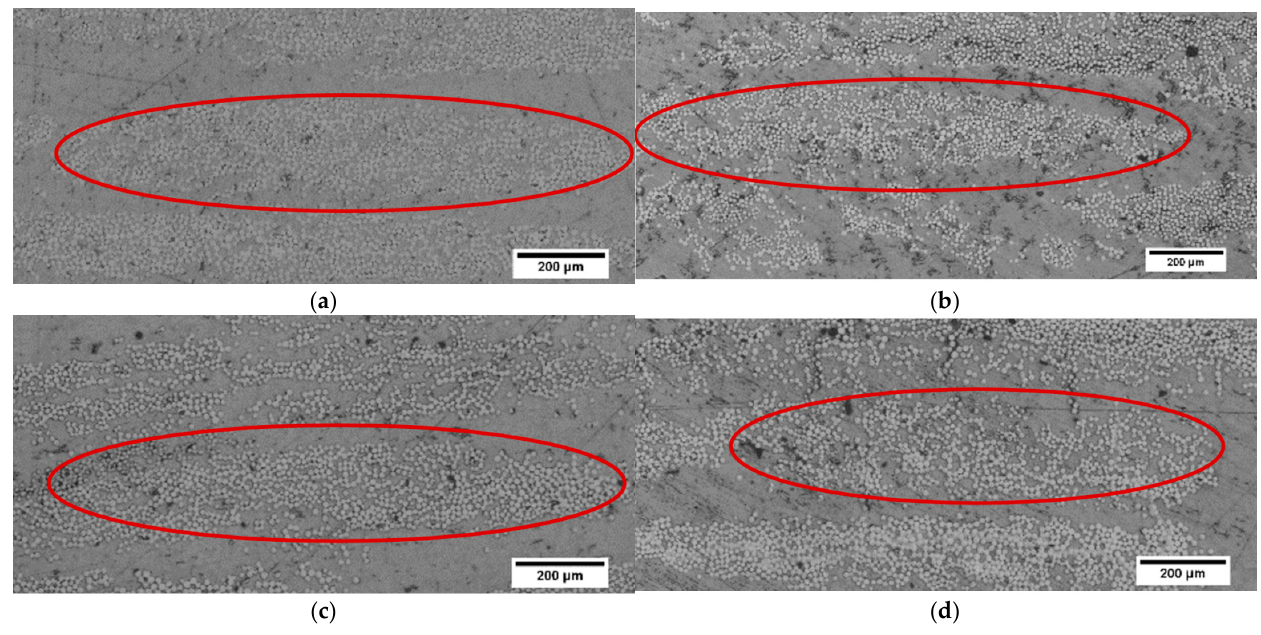
Figure 5. MFI against temperature for ( a ) PP and ( b ) PP with 3 wt% MAPP.